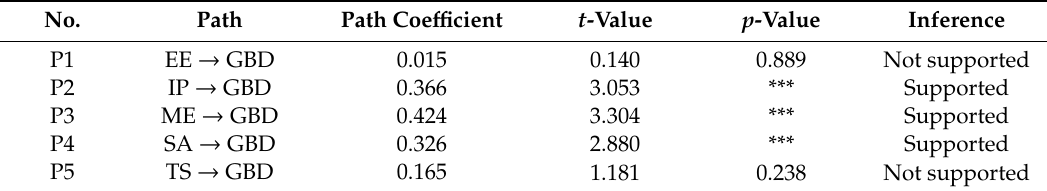
Table 9. Evaluation results of the structural